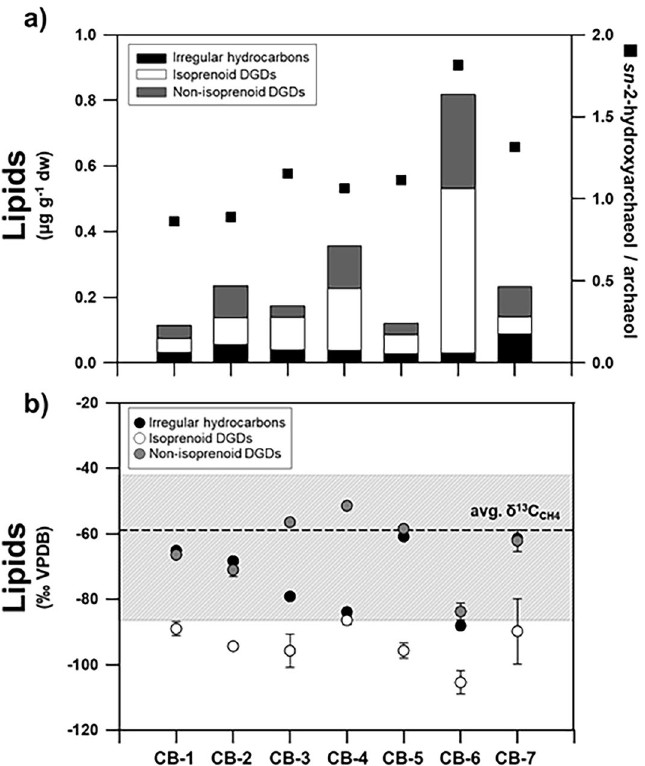
Figure 3. Lipid biomarker signatures of authigenic carbonates from the CB: ( a ) concentrations of major lipid biomarkers and ratios of sn -2-hydroxyarchaeol relative to archaeol, and ( b ) carbon isotopic compositions of major lipid biomarkers. Note that the dashed line indicates the average value of δ 13 C of methane (δ 13 C CH4 ) while the shaded area shows the full range of δ 13 C CH4 values.